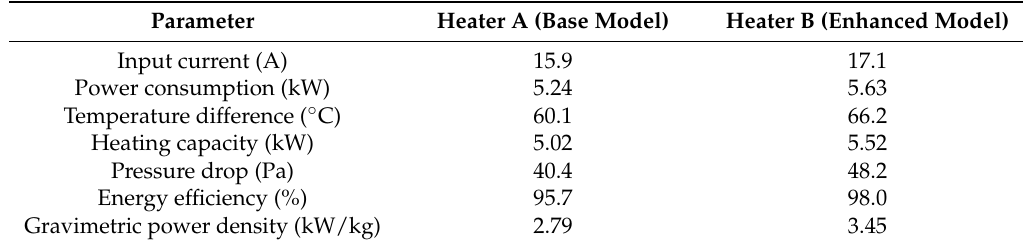
Table 7. Comparison of heating performance between PTC Heaters A and